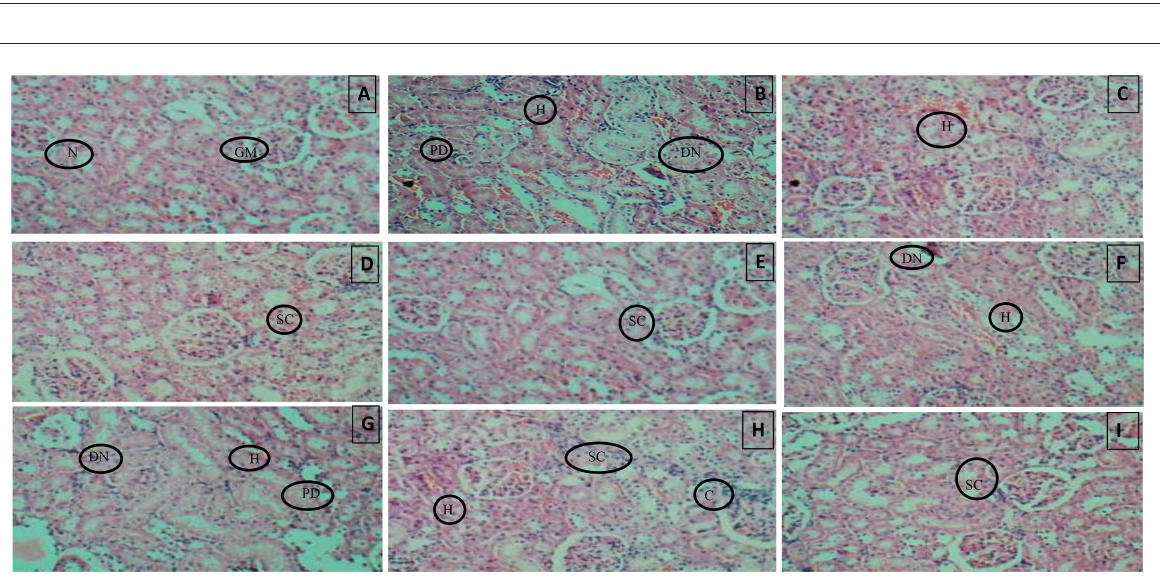
Liver The liver of diabetic rats administered with metformin and Acarbose showed a highly significant increase ( p < 0.001) in SOD, while other antioxidant defense enzymes presented a comparable increase/decrease with all oral